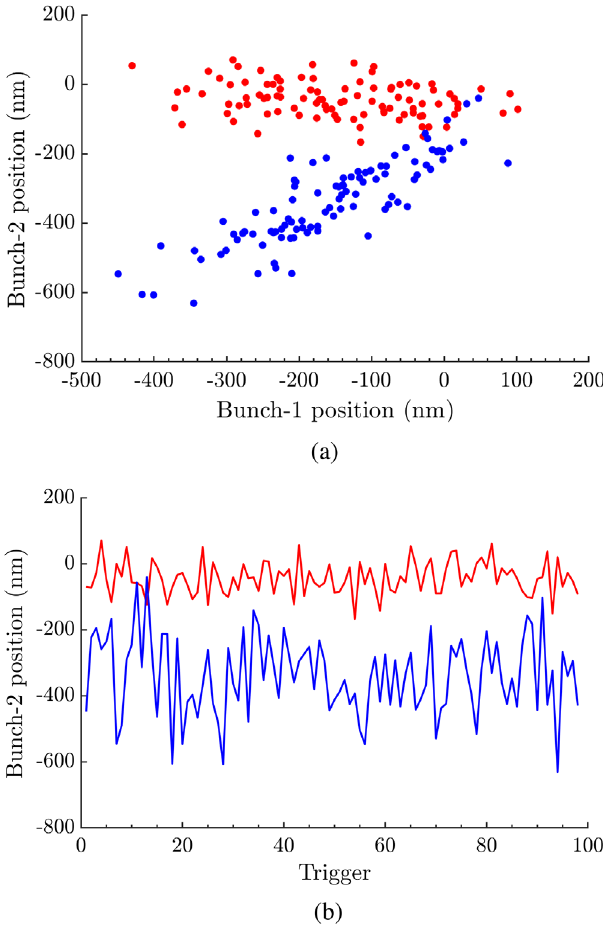
FIG. 17. (a) IPC bunch-2 position versus bunch-1 position and (b) bunch-2 position versus trigger number; for feedback off (blue) and feedback on (red).